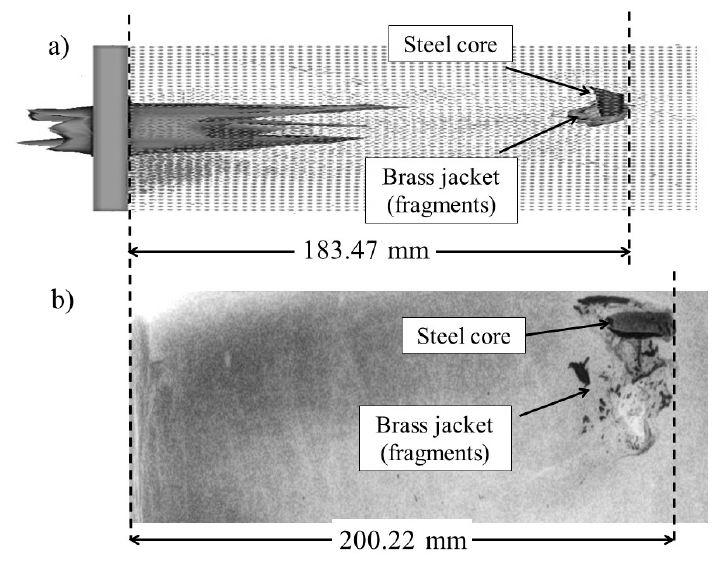
Figure 6. Comparison of fragmentation and penetration depths of the 7.62 mm AP bullet in the PSP block from ( a ) numerical simulation and ( b ) X-ray photography.